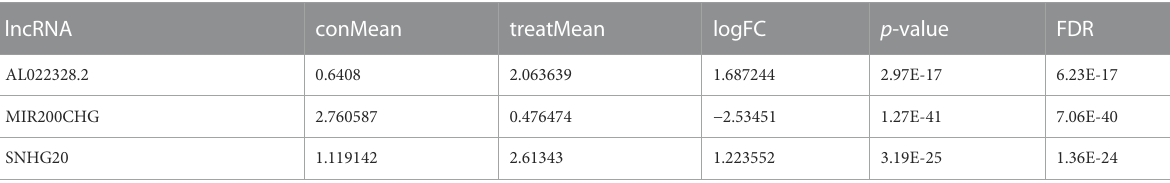
TABLE 1 ( Continued ) Lipid metabolism-related lncRNAs acquired posterior to differential expression analyses.